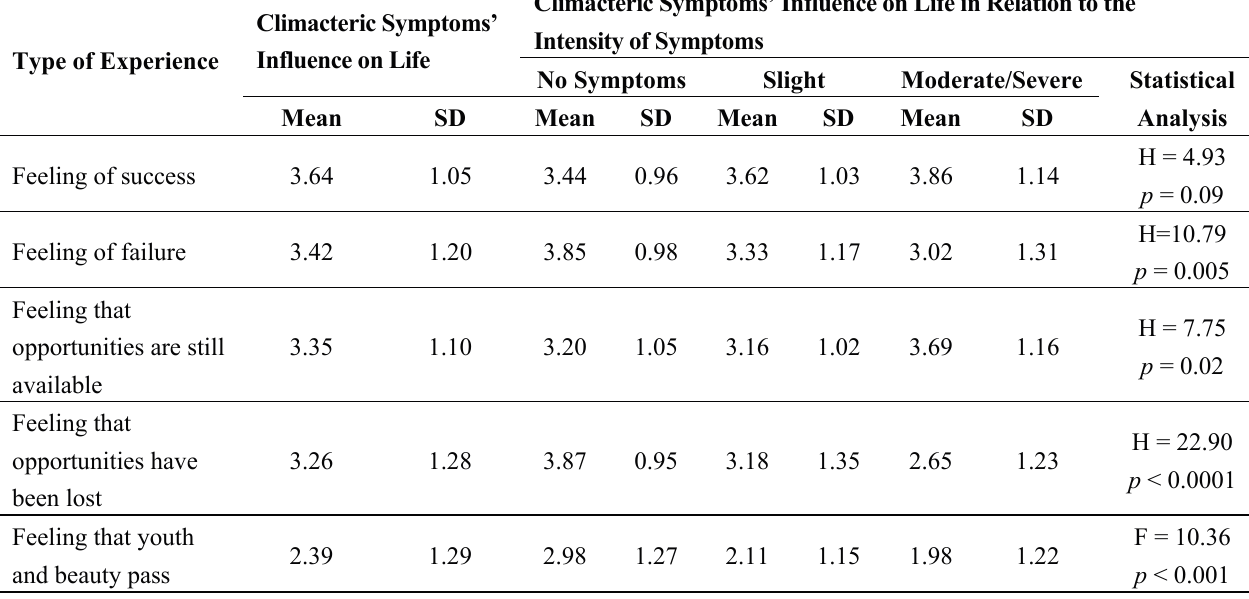
Table 4. Assessing the climacteric symptoms’ influence on